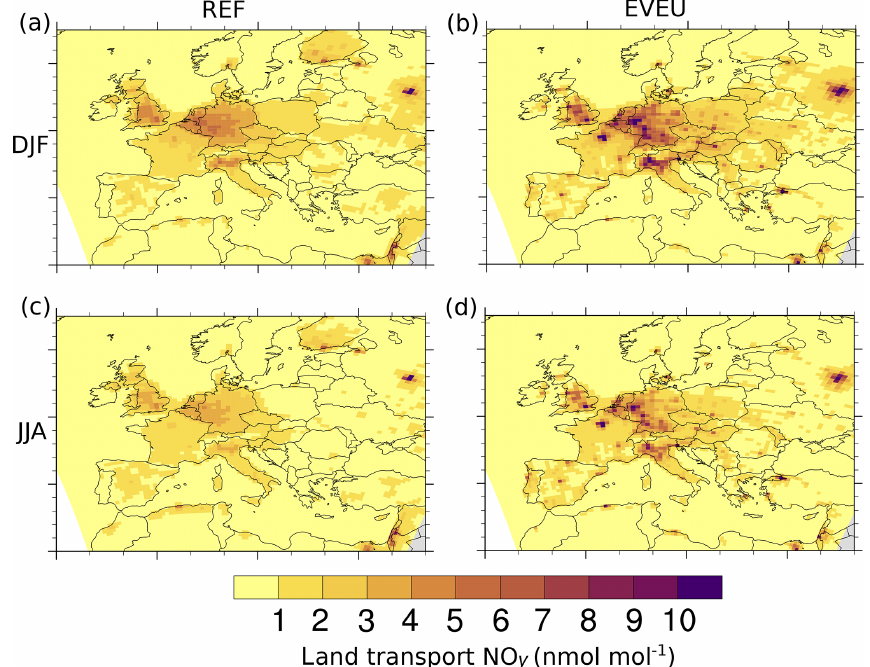
Figure 3. Absolute contribution of land transport emissions to ground-level NO y (in nmolmol − 1 ) as simulated by CM50. Panels (a) and (b) are contributions for the period DJF (2008 to 2010) of the REF and EVEU simulations, respectively. Panels (c) and (d) are contributions for the period JJA (2008 to 2010) of the REF and EVEU simulations,